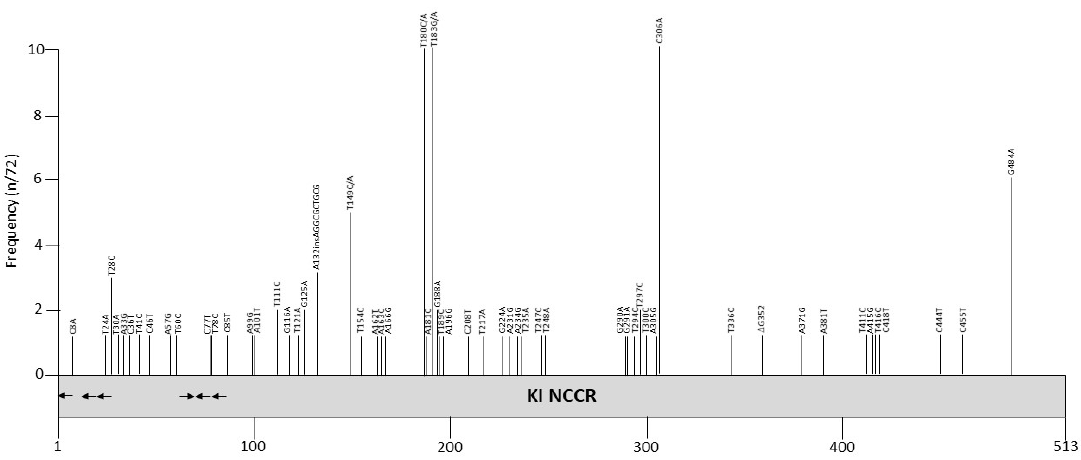
Figure 2. Mutations and their prevalence in variants of Karolinska Institute polyomavirus (KIPyV) noncoding control region (NCCR). The numbering of the NCCR is from early to late, with nucleotide 1 being the most proximal to the ATG start codon of the early genes and the most distal nucleotide, just upstream of the start codon of the VP2 gene. The number of times a peculiar mutation is found in the different variants is given as frequency (with n the number of times the mutation was described/total NCCR variant sequences available). Putative Large T antigen (LT) binding motifs 5 ′ - GRGGC-3 ′ ( → ) or 5 ′ -GCCYC-3 ′ ( ← ) are shown. The table summarizes the mutations, their location in